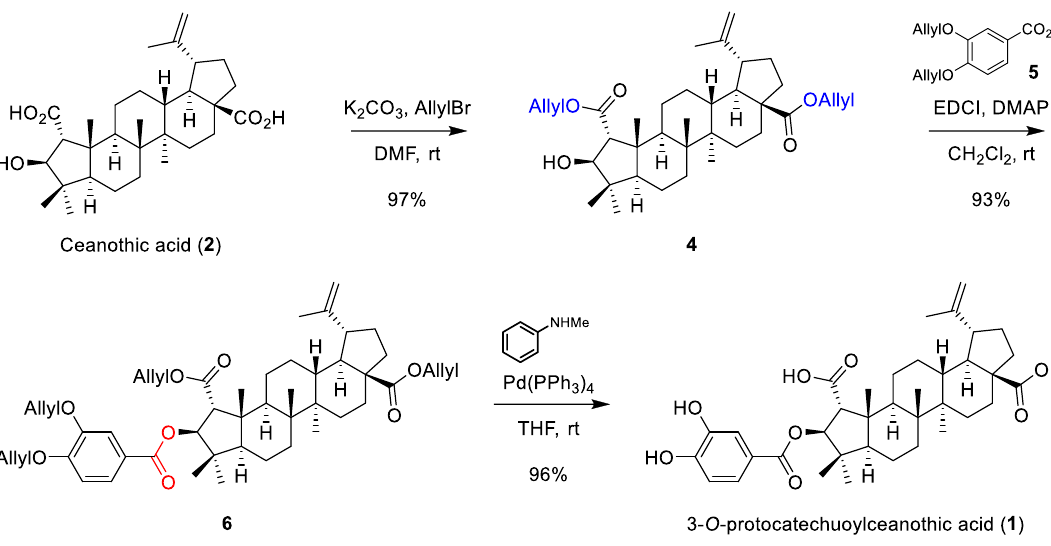
Figure 3. Initial strategy for the direct esterification of ceanothic acid ( 2 ) and benzoic acid 3 .